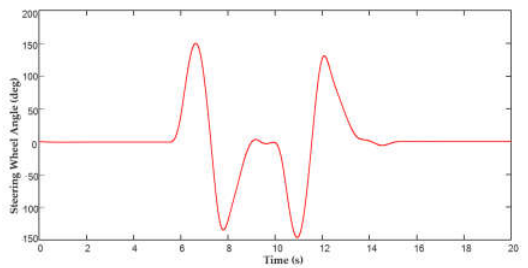
Figure 11. Steering wheel angle at the double shift line condition.